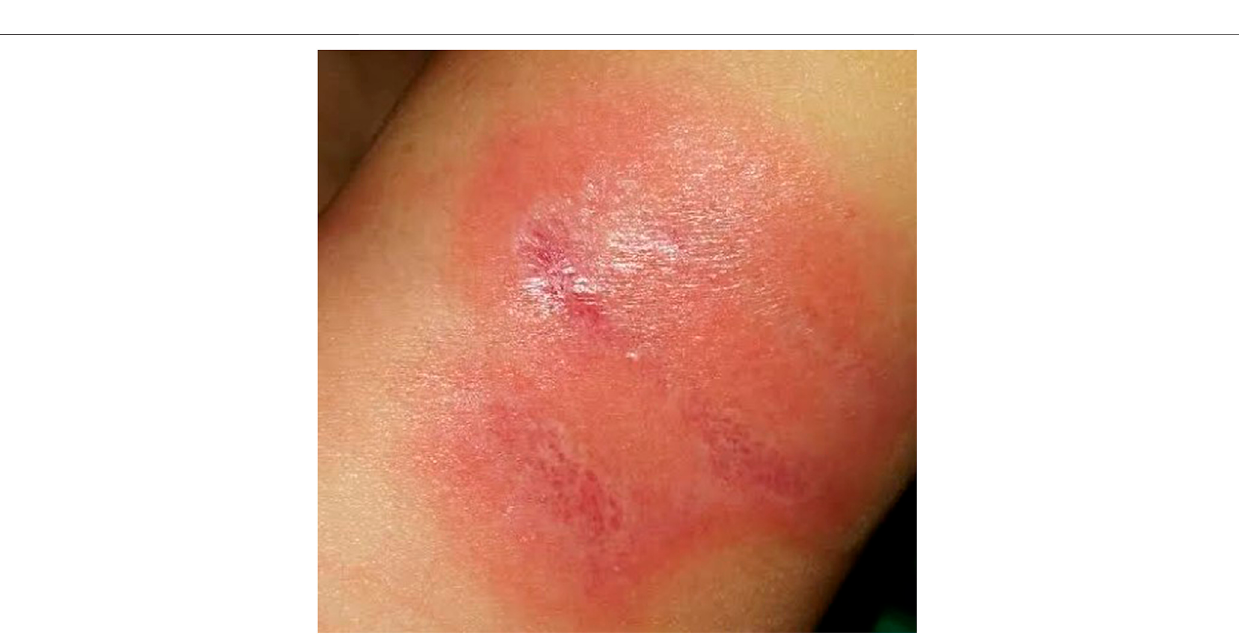
FIGURE 6 | Wound after 3 weeks of using BC